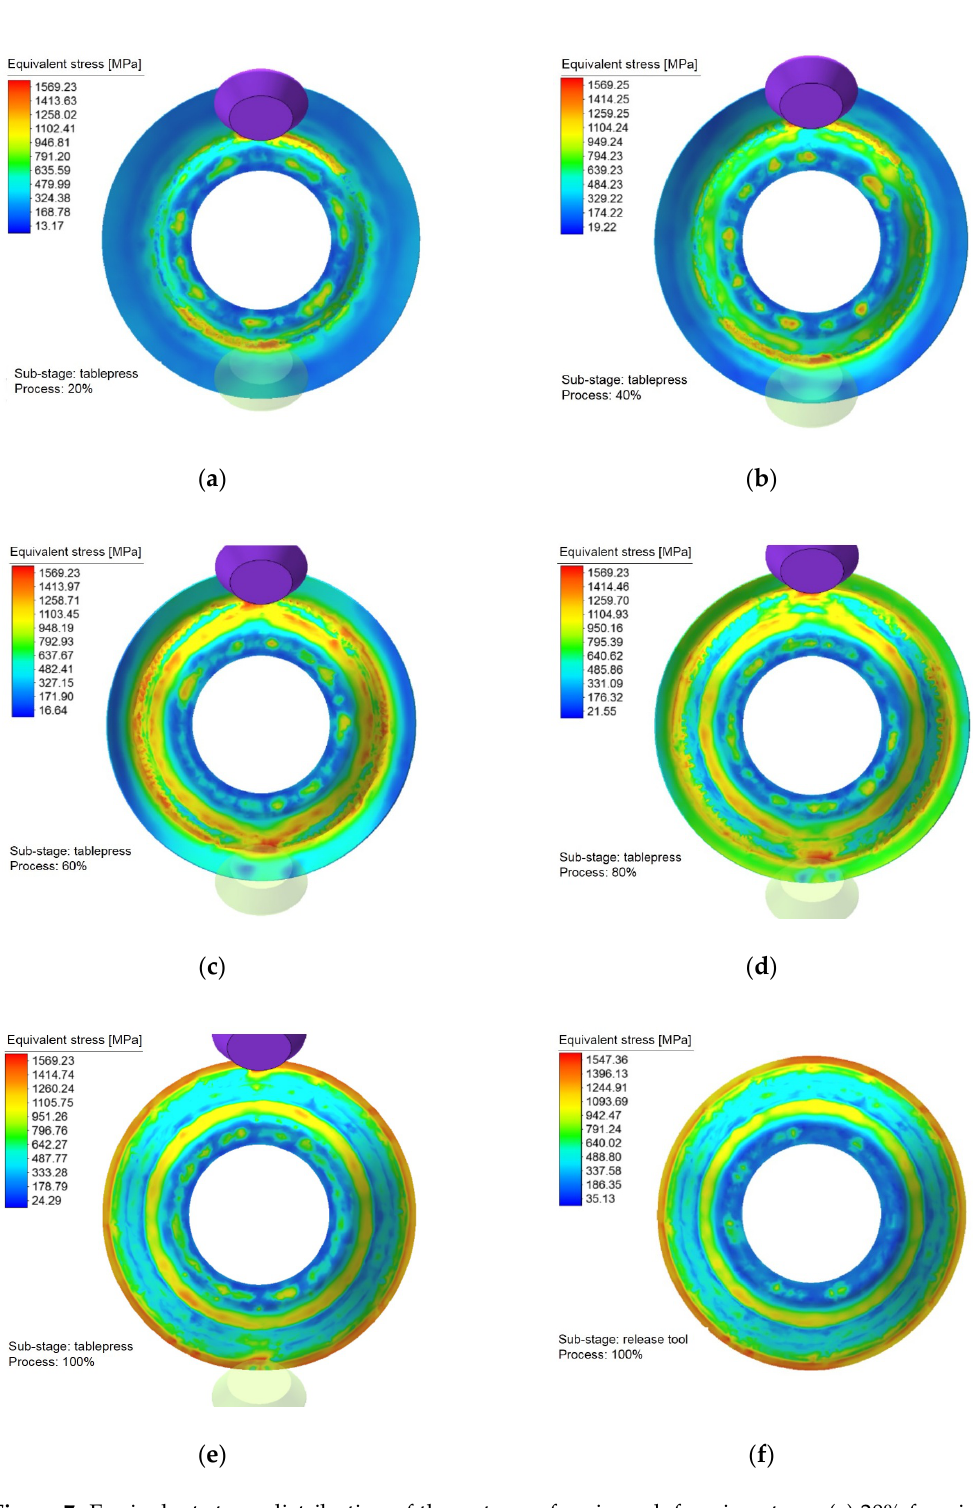
Figure 7. Equivalent stress distribution of the outer surface in each forming stage: ( a ) 20% forming process; ( b ) 40% forming process; ( c ) 60% forming process; ( d ) 80% forming process; ( e ) 100% forming process; and ( f ) after the roller unloading.